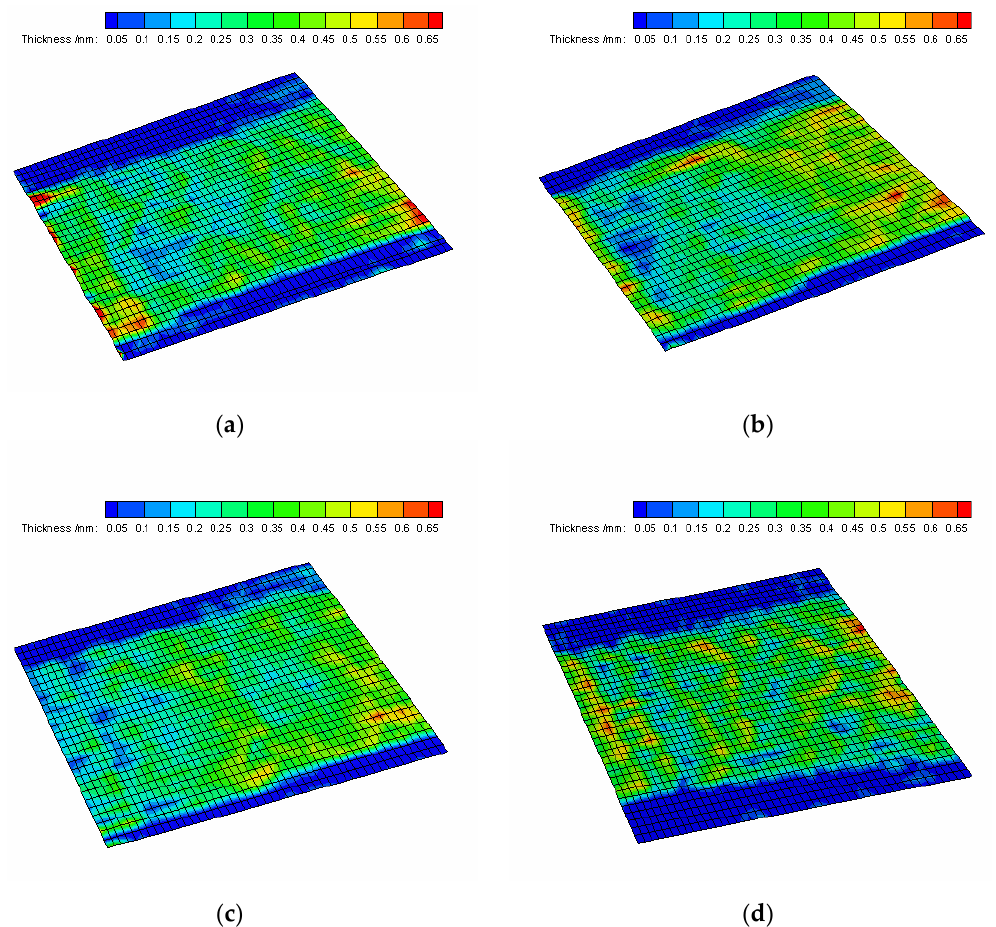
Figure 6. DIP measurement results under different roughness: ( a ) Rz = 20.6 µ m; ( b ) Rz = 23.7 µ m; ( c ) Rz = 62.3 µ m; ( d ) Rz = 85.3 µ